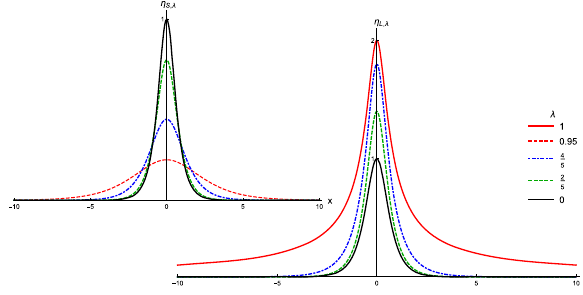
Fig. 9 Thezeromodesforthelargekink(27)(right)andthesmallkink (29)(left),depictedforsomevaluesof λ .Bothmodesbehaveadequately for λ (cid:8)= 1. However, for λ = 1, we have η S ,λ = 1 = 0, meaning that the small topological sector disappears, while η L ,λ = 1 ( x (cid:9) ∞ ) (cid:9) 1 / x 2